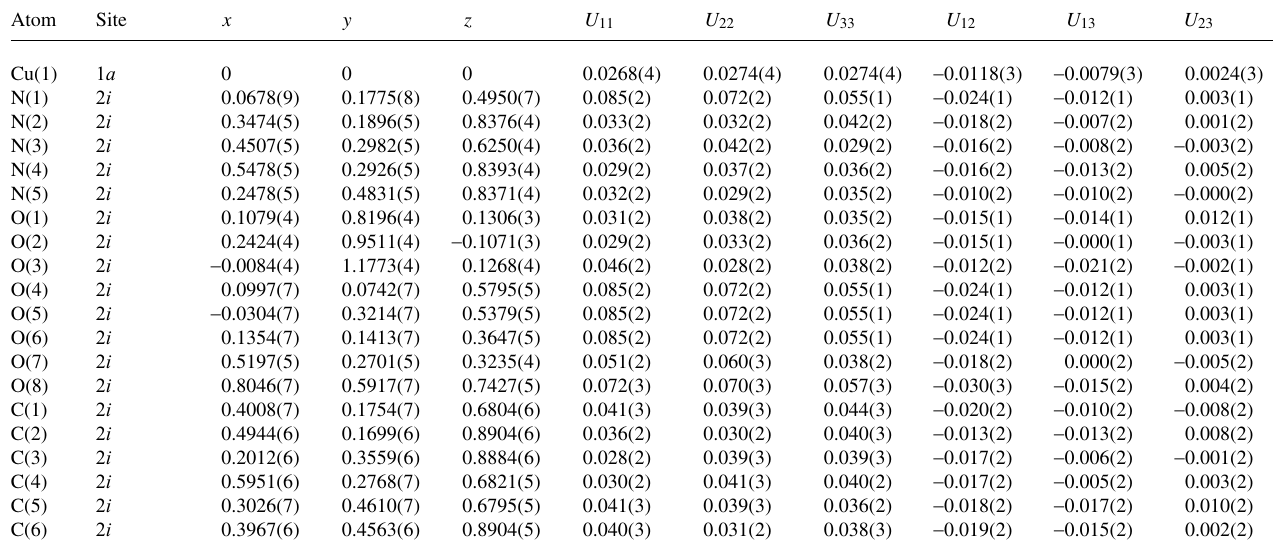
Table 3. Atomic coordinates and displacement parameters (in Å 2 )